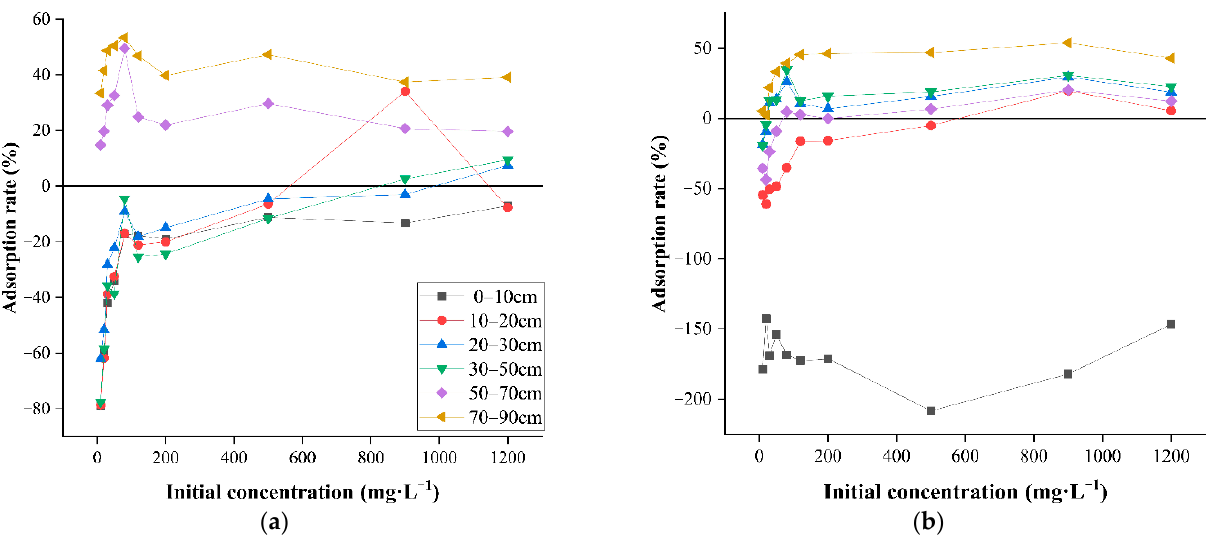
Figure 9. Changes in the adsorption rate of the soil within SIA for Cr (VI) with initial concentration